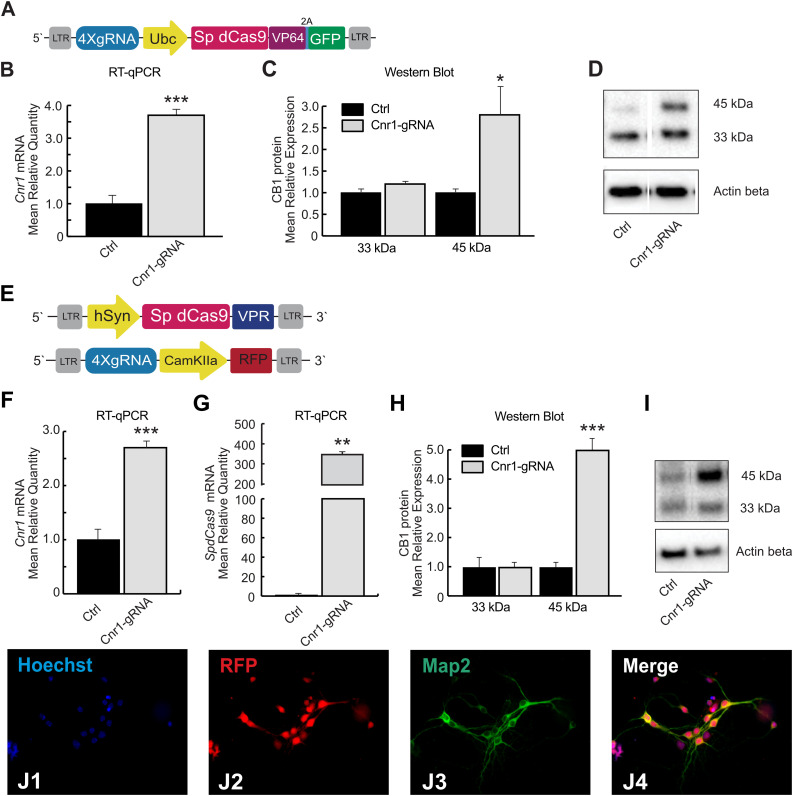
SpdCas9 based lentiviral system and modulation of Cnr1 gene expression in vitro. (A) Schematic illustrating the main components of the single lentiviral vector LV-SpdCas9-VP64-Cnr1. (B) mRNA expression level of the Cnr1 gene in primary neurons transduced with the single lentiviral vector LV-SpdCas9-VP64-Cnr1 (Cnr1-gRNA) compared with controls (Ctrl) (Unpaired Student’s t-test, ***p < 0.001). (C) Expression level of the two immunoreactive CB1 bands (∼33 and 45 kDa) in primary neurons (Cnr1-gRNA vs. Ctrl, Unpaired Student’s t-test, *p < 0.05). (D) WB analyses of total protein lysates from primary neurons. The upper panel shows the detection of the immunoreactive CB1 bands (∼33 and 45 kDa) and the lower panel shows β-actin detection for loading control. (E) Schematic of the main components of the dual viral vector system LV-SpdCas9-VPR and LV-Cnr1-gRNA. (F) mRNA expression level of the Cnr1 gene in primary neurons transduced with the dual viral vector system LV-SpdCas9-VPR and LV-Cnr1-gRNA (Cnr1-gRNA) compared with controls (Ctrl) (Unpaired Student’s t-test, ***p < 0.001). (G) mRNA expression level of the spdCas9 gene in primary neurons (Unpaired Student’s t-test, **p < 0.01). (H) Expression level of the two immunoreactive CB1 bands (∼33 and 45 kDa) in primary neurons (Cnr1-gRNA vs. Ctrl, Unpaired Student’s t-test, ***p < 0.001). (I) WB analyses of total protein lysates from primary neurons. (J1–J4) Representative micrographs obtained with fluorescence microscopy of cortical primary neurons. The images show the Hoechst nuclear staining (Blue; J1), RFP expression (Red; J2) and GFP (Green; J3) expression. Scale bar: 80 μm.